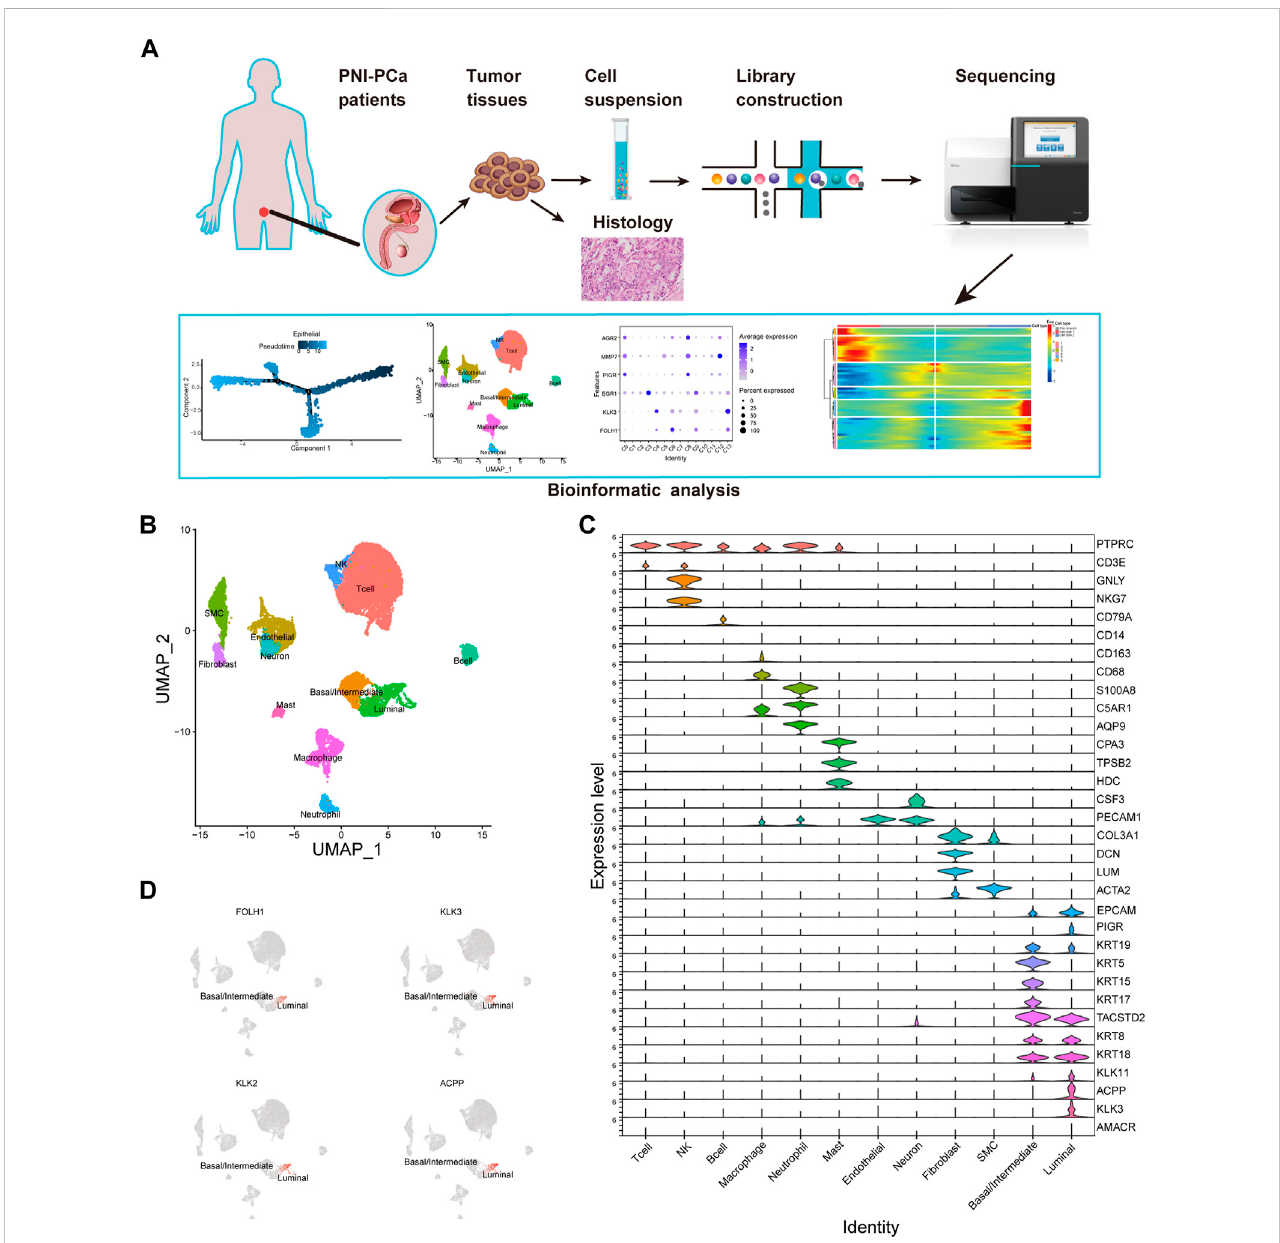
FIGURE 1 Diverse cell types in PNI-PCa were identi fi ed by single-cell sequencing. (A) Single-cell sequencing fl ow chart. (B) UMAP exhibits the cell clusters in PNI- PCa and different colors labeled for different cell types according to their featured gene expression pro fi les. (C) Violin plots show the expression levels of marker genes for each cell type. (D) UMAP shows the expression of prostate cancer-speci fi c genes localized speci fi cally to the luminal epithelial